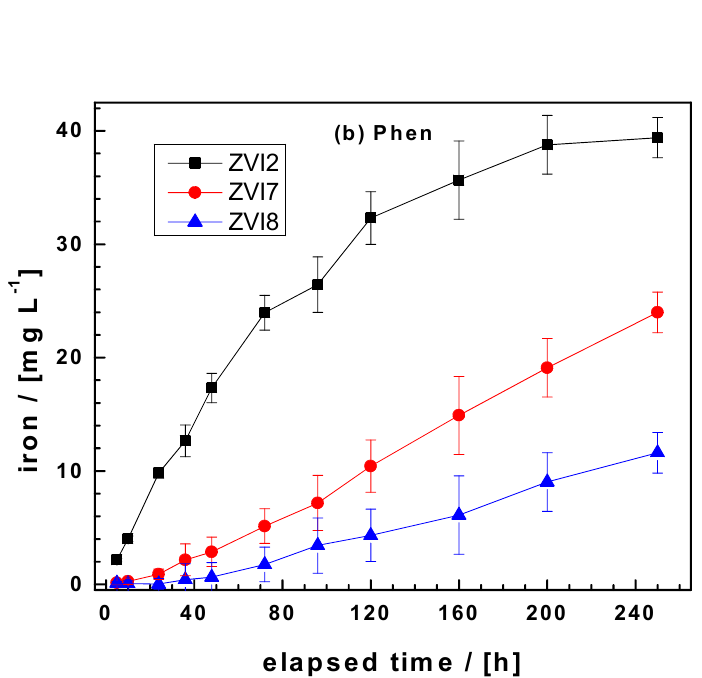
Figure 3. Iron dissolution from ZVI2, ZVI7, and ZVI8 by 2 mM EDTA and 2 mM Phen under quiescent conditions for 10 days (250 h). The three samples are representative of the tested materials. Error bars denote the standard error for triplicate experimental results. Experimental conditions: V = 50 mL, m ZVI = 0.1